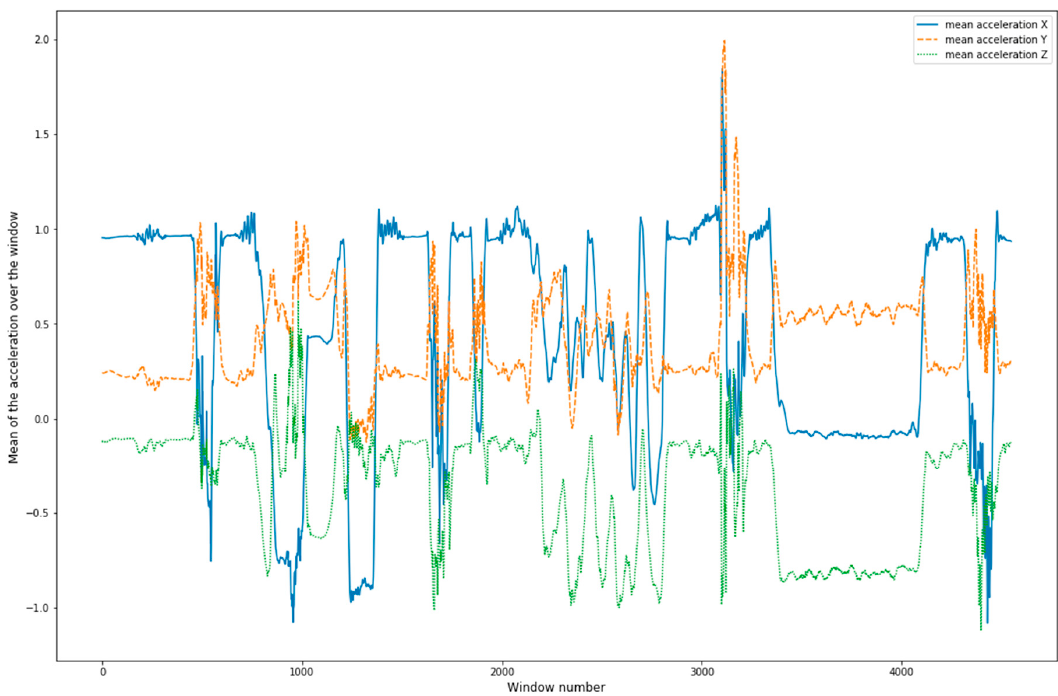
Figure 4. Tri-axial angular acceleration of participant 1.